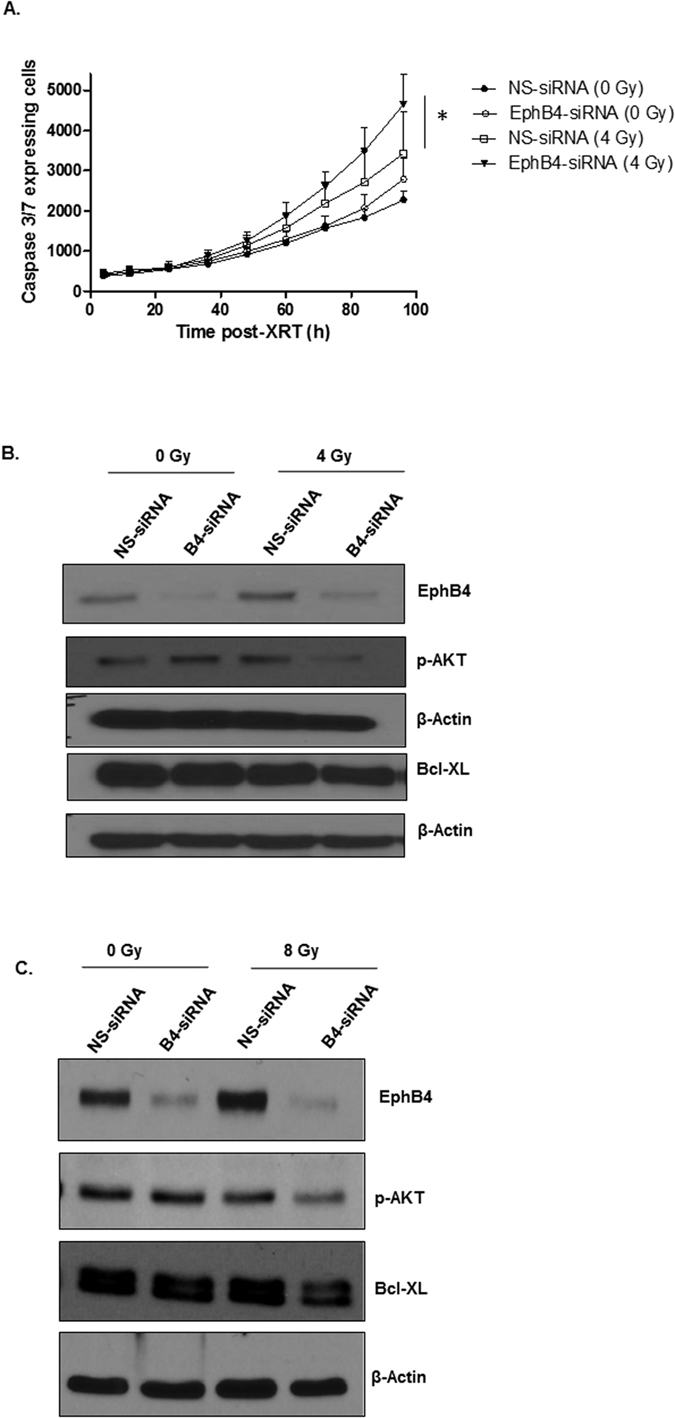
Combined EphB4 knockdown and ionizing radiation exposure induces apoptosis in HNSCC cells.EphB4 knockdown combined with radiation enhances apoptosis in Fadu cells as shown by caspase 3/7 assay (A). Western blot analysis show modulation in the levels of pro-survival markers in Fadu (B) and MSK-921 (C) cells following EphB4 knockdown and radiation exposure (XRT). Each experiment was repeated atleast two times. Data shown represent mean ± standard error from two independent experiments. *p < 0.05.